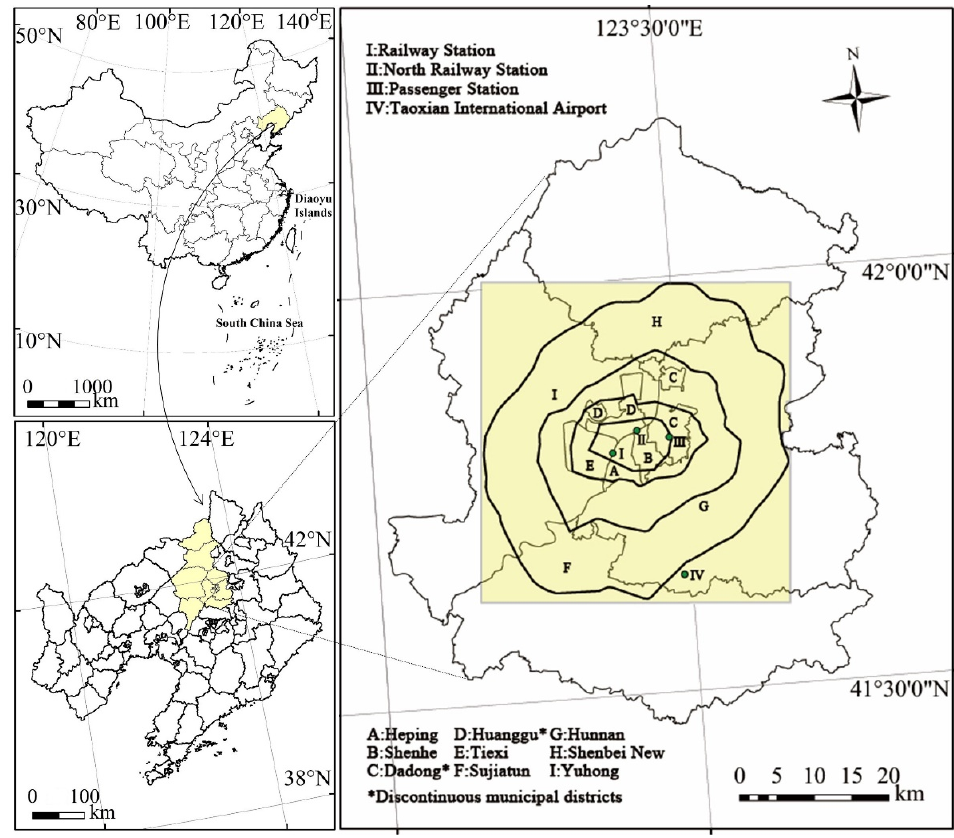
Figure 1. Research